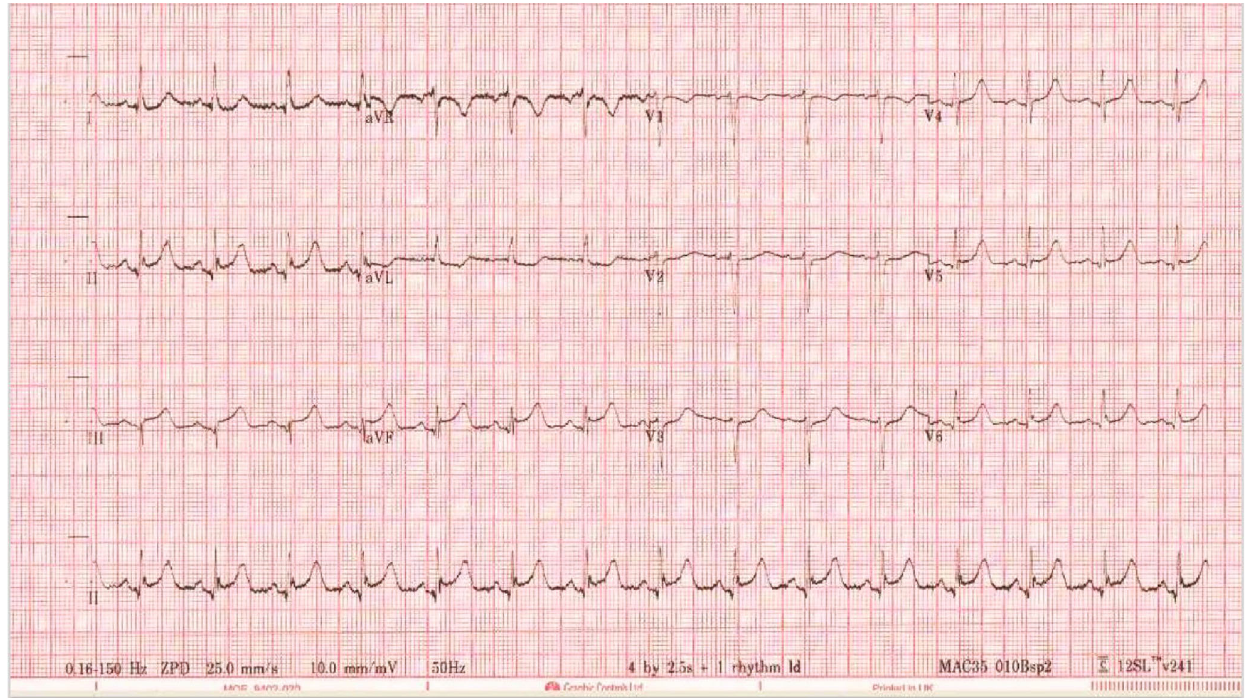
Figure 1: ‘ Abnormal ECG. ’ This fi gure is a 12-lead ECG which was taken after resuscitation from cardiac arrest. It shows ST elevation at the J point in leads II, III, and